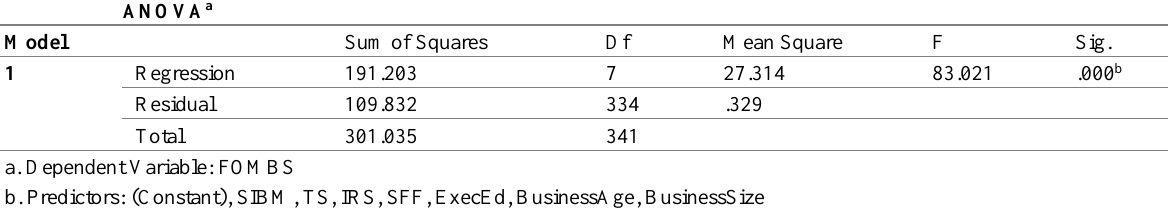
Table 5: ANOVA F-test in regression model